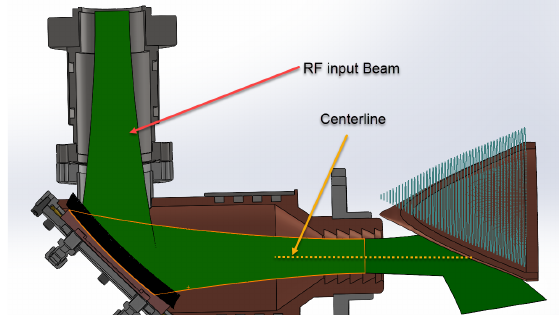
Fig. 4. RF beam path through input coupler